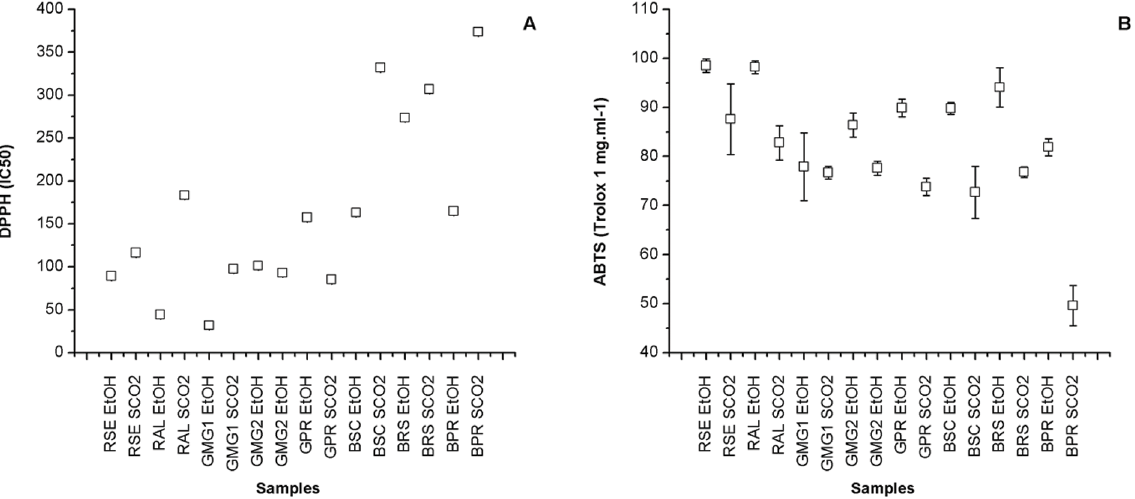
Fig 4. Determination of antioxidant activity of the extracts from different samples of Brazilian propolis, by DPPH (IC 50 ) (A) and ABTS (Trolox 1 mg.ml -1 ) (B). SCO 2 – Extracts obtained by SFE; EtOH – Extracts obtained by ethanolic extraction; Average of analysis obtained in triplicate (n =